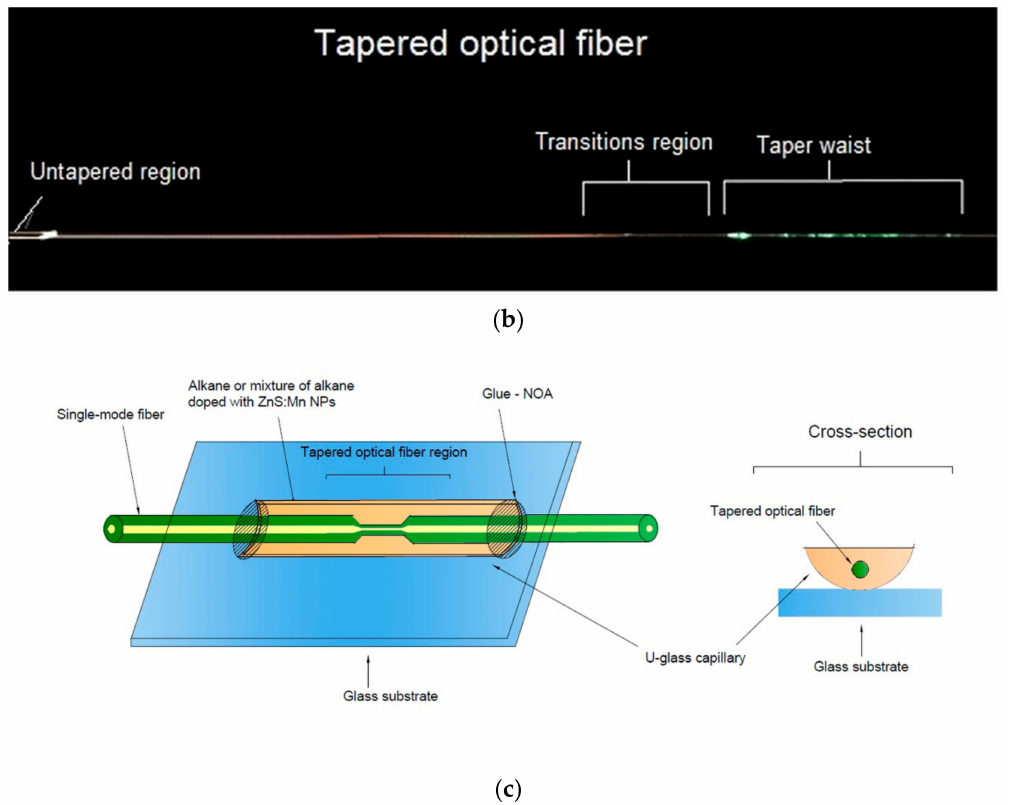
Figure 2. ( a ) Scheme of a set-up for preparing a tapered optical fiber, ( b ) tapered optical fiber manufactured on Fiber Optic Taper Element Technology (FOTET), and ( c ) scheme of the prepared sample for a transmission measurement.